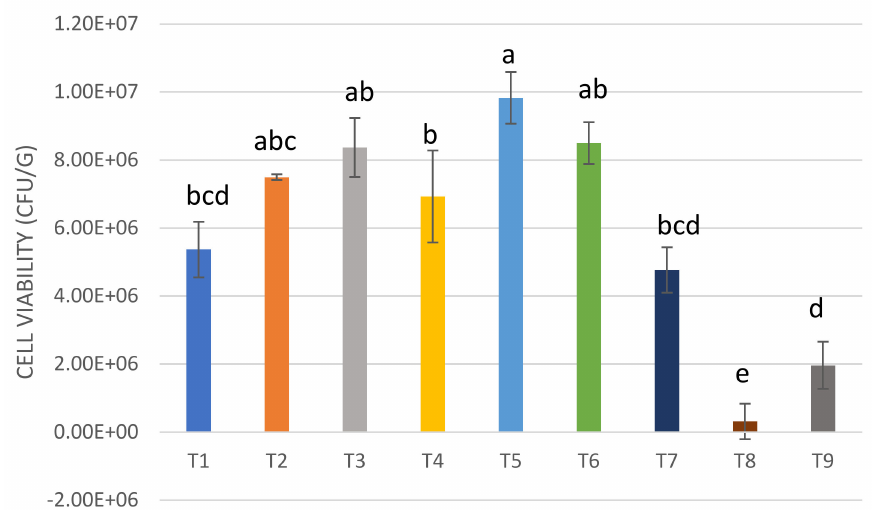
Figure 2. Comparison between cell counts of yogurt formulations at Day 28 of storage with refrigeration. The experimental values (means and standard deviations for n = 3) that have no common superscript are significantly di ff erent ( p < 0.05); where a is the highest viability and e the lowest viability. Legend: